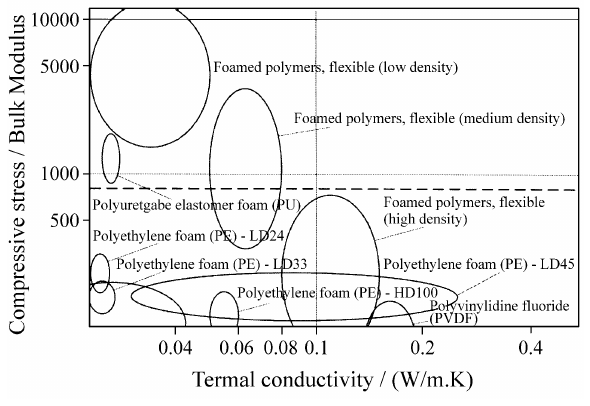
Figure 7. Materials Property Map from which selection of foams com- bining a given deformation under load with high thermal conductivity, can be carried